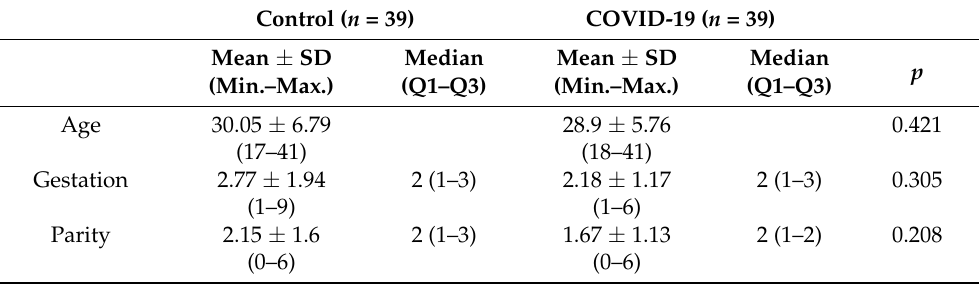
Table 1. Baseline characteristics of the tested patients: control and COVID-19 positive, in connection with the variables age, gestation, parity.